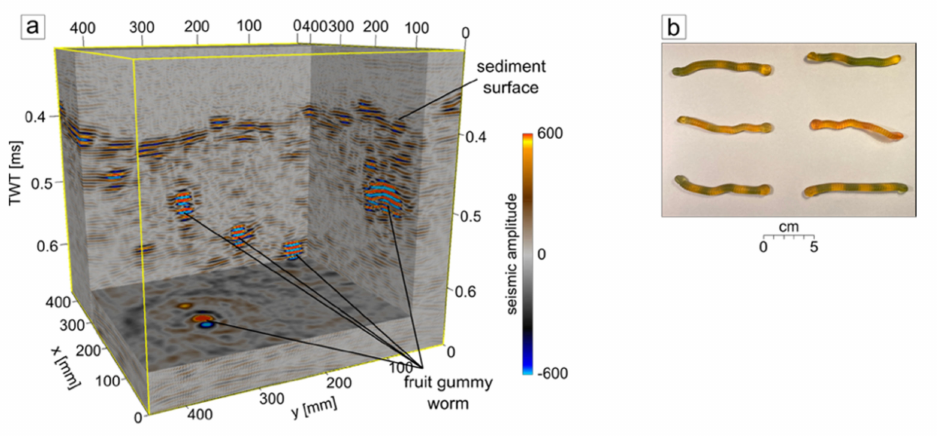
Figure 5. ( a ) Seismic volume showing the reflections of fruit gummy worms in 0.45 to 0.65 ms TWT depth. Five of six gummy worms buried during the experiment are visible. The gummy worm to the right is measured along its long axis. Its vertical extension is measured with 0.02 ms TWT (1.5 cm at 1500 m/s water sound velocity) and its length with 40 shot points (10 cm with 2.5 mm shot point distance). ( b ) Photography of the fruit gummy worms showing the plan view of the configuration they are buried in (the average worm is 11.5 cm in length and 0.7 cm wide). Due to their flexibility, buried worms might show small